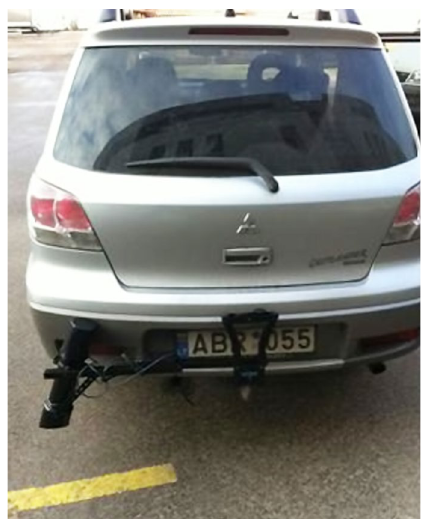
Fig. 4. Sensor for measurement of friction (RCM 411) installed on a tow-ball of a vehicle (Bulevičius et al. 2014)